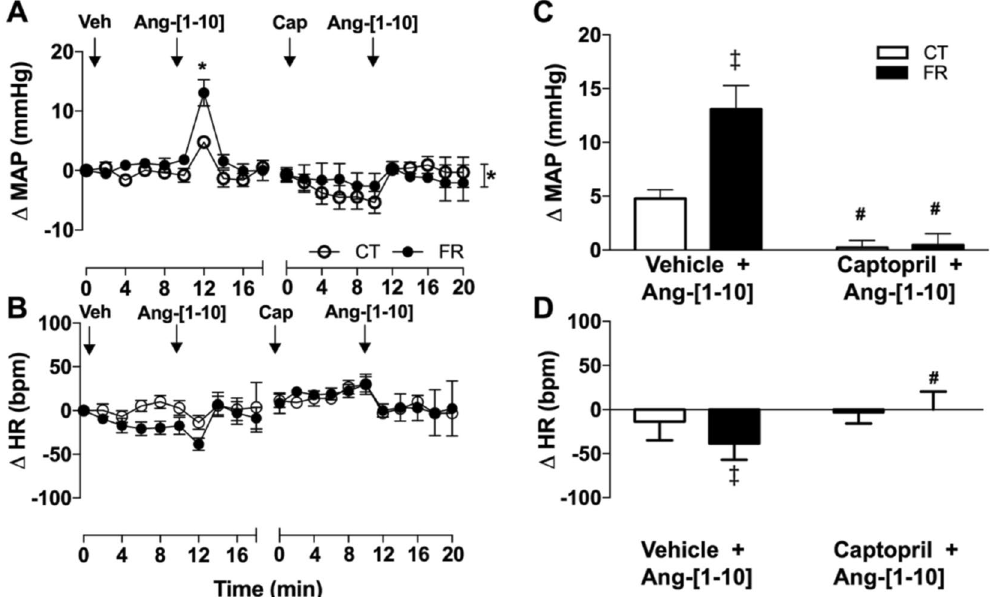
Figure 2. Effect of FR on MAP and HR responses to infusion of Ang-[1–10]. Shown are the changes ( A , B ) or maximum changes from baseline ( C , D ) in MAP ( A , C ) and HR ( B , D ) after vehicle (Veh), Ang-[1–10] or captopril (Cap) infusion in CT (open circle) and FR (closed circle) female rats (n = 7/group). Basal MAP (mm Hg): CT, 106 ± 1.3 vs. FR, 104 ± 3.0. Basal HR (bpm): CT, 368 ± 13 vs. FR, 355 ± 14. * P < 0.05 vs. CT by two- way ANOVA and Bonferroni post-hoc test (time; diet); # P < 0.001 vs. vehicle, same animal group by unpaired Student’s t -test and ‡ p < 0.002 vs. CT, same treatment, by two-way ANOVA and Bonferroni post-hoc test (drug; diet). Values are expressed as the mean ± SEM.